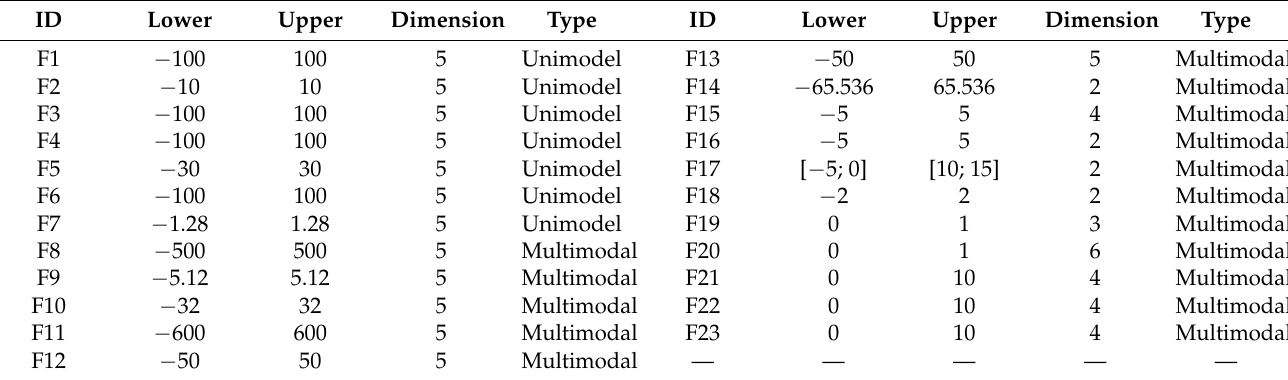
Table 1. Description of the benchmark